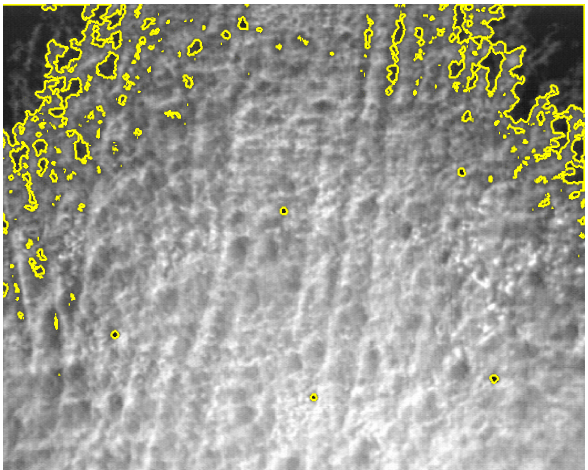
Figure 8: Boundaries from thresholding (yellow); Input image as background.